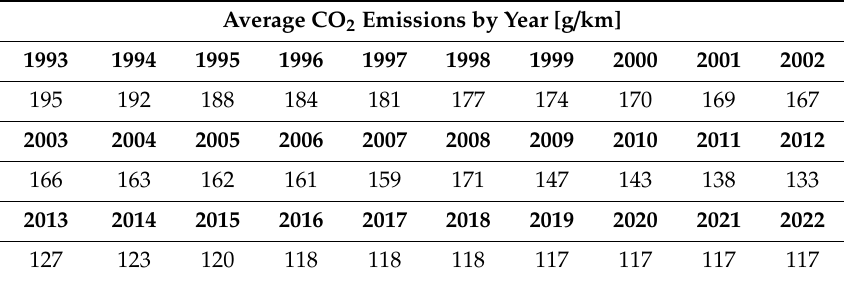
Table 7. Average CO 2 emissions in European Union, Norway and Switzerland in years 1993–2022 [g /